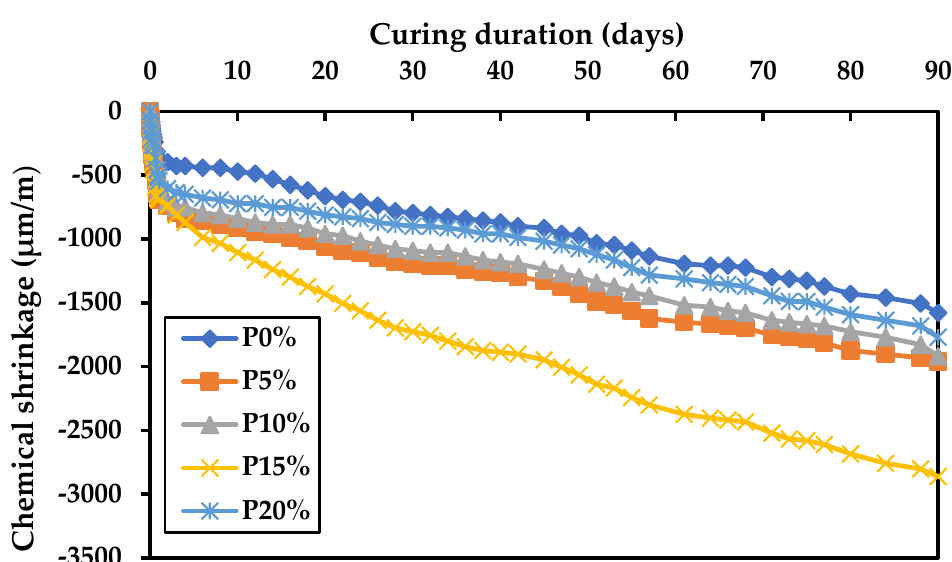
Figure 6. Chemical shrinkage of pastes with different percentages of LF over 90 days.